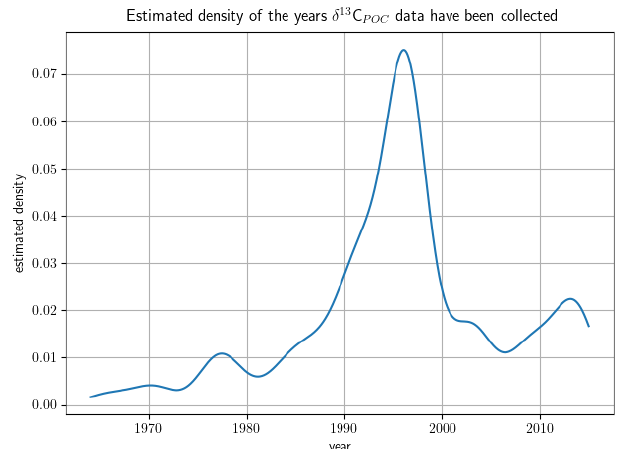
Figure 8. The distribution of δ 13 C POC data samples over the years approximated by Gaussian KDE. The density is drawn on the y axis; the sample year is on the x axis. A higher altitude of the graph indicates years with more available data.